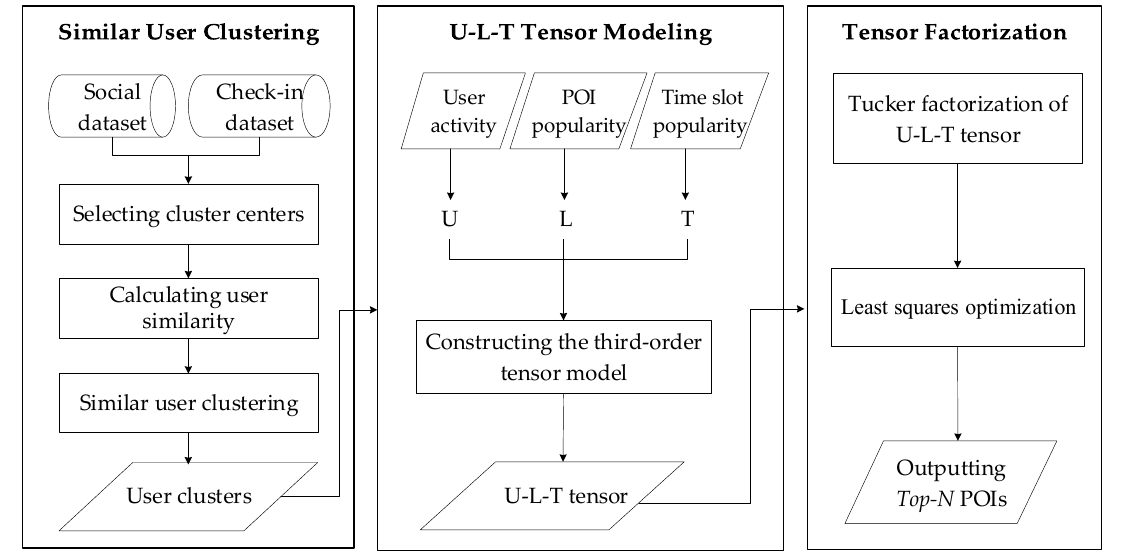
Figure 1. Framework of the CULT-TF method.